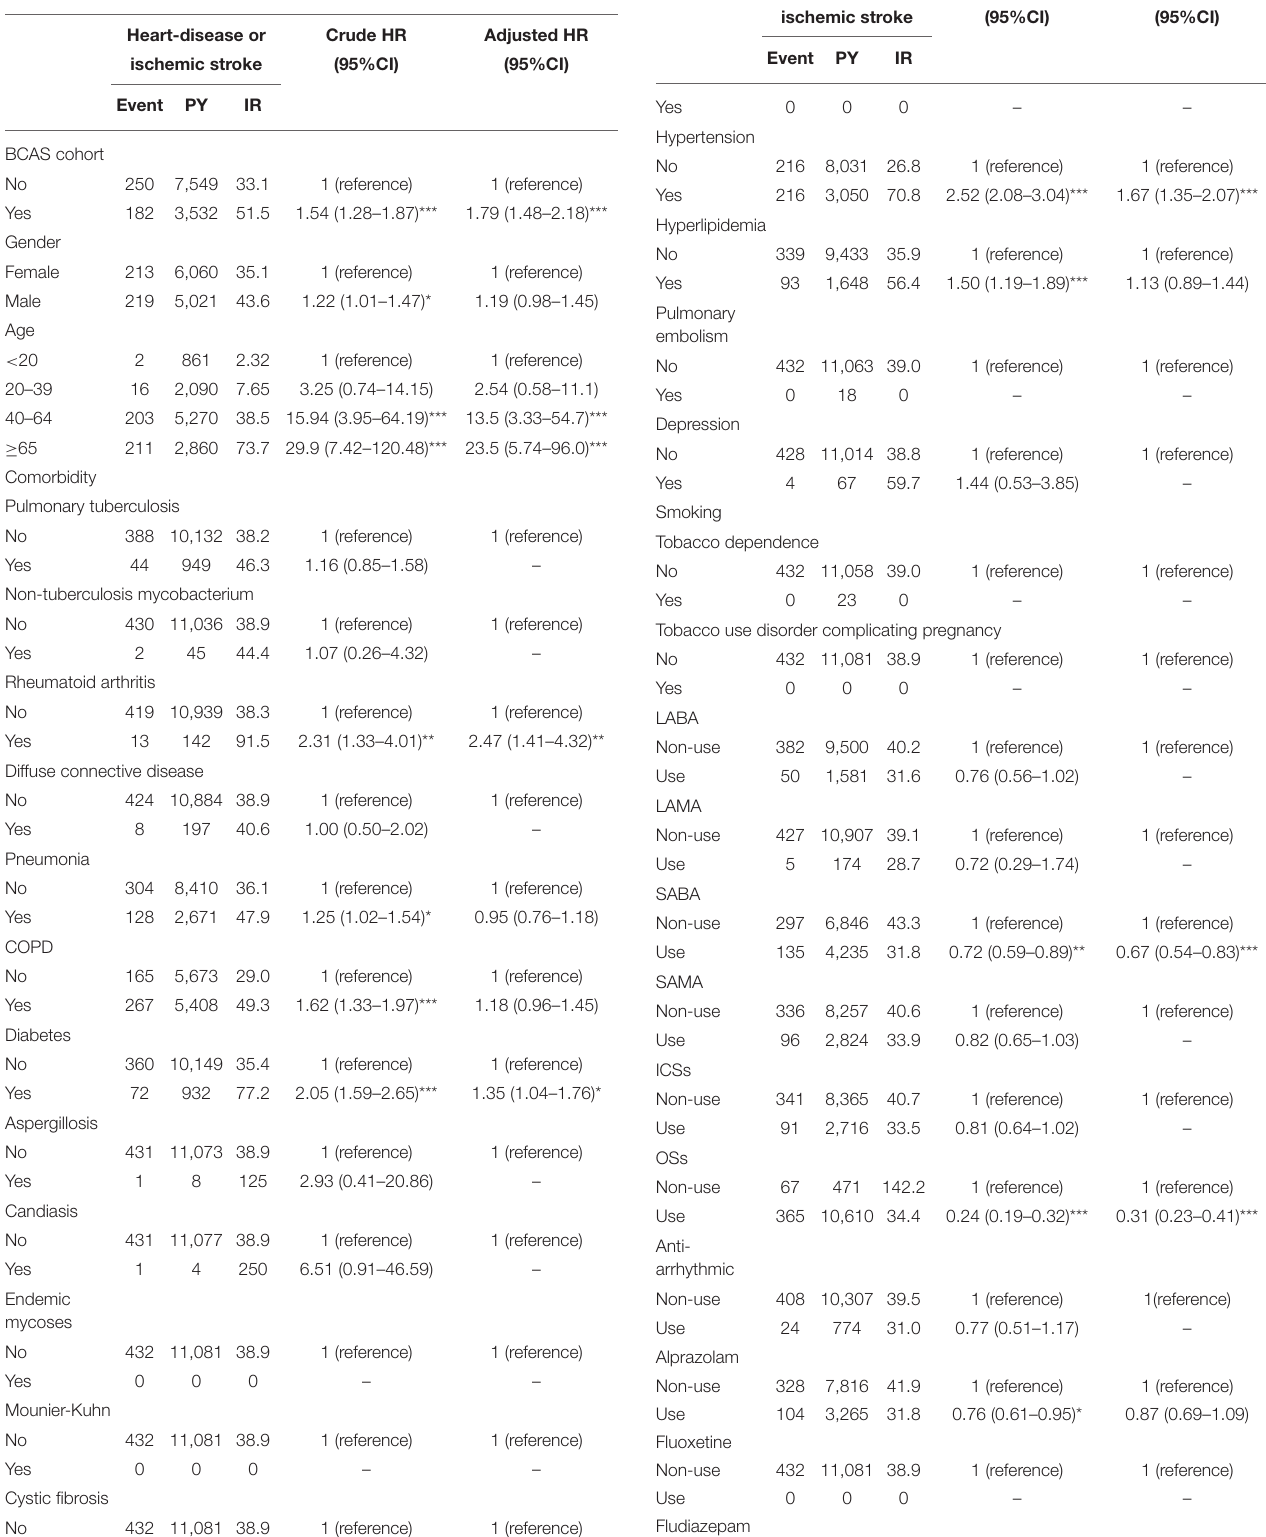
TABLE 2 | Cox model measured hazard ratios and 95% confidence interval of heart-disease or ischemic stroke associated with gender, age, and comorbidity after propensity matching between two